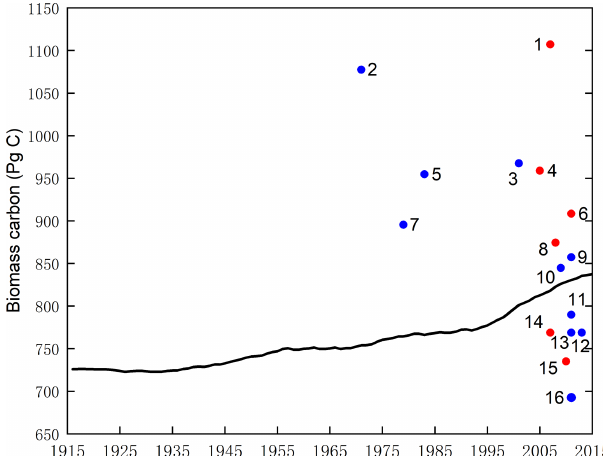
Figure 5. Estimates of the potential vegetation biomass carbon stock from the literature (blue plot), state-of-the-art datasets (red plot), and this study (black line). Datasets are from the following studies: (1) Erb et al. (2018, 2007), (2) Bazilevich et al. (1971), (3) Saugier et al. (2001), (4) Erb et al. (2018) and Bartholome and Belward (2005), (5) Olson et al. (1983), (6) Erb et al. (2018) and Pan et al. (2011), (7) Ajtay et al. (1979), (8) Erb et al. (2018) and Ruesch and Gibbs (2008), (9) Kaplan et al. (2011), (10) Shevli- akova et al. (2009), (11) Kaplan et al. (2011), (12) Pan et al. (2013), (13) Prentice et al. (2011), (14) Erb et al. (2018, 2007), (15) Erb et al. (2018) and West et al. (2010), (16) Hurtt et al.